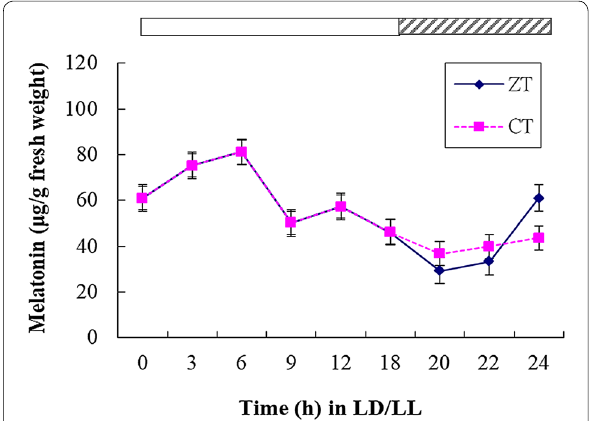
Fig. 3 Rhythmic changes in melatonin concentrations in H. perforatum L. leaves with time under 18‑h light:6‑h dark photoperiodic cycles ( Zeitgeber time, ZT; solid diamonds) and constant light conditions (circadian time, CT; solid squares). The white bar at the top indicates the light period. The black‑shaded bar at the top indicates the dark period and the subjective night. Data are the mean of three replicates